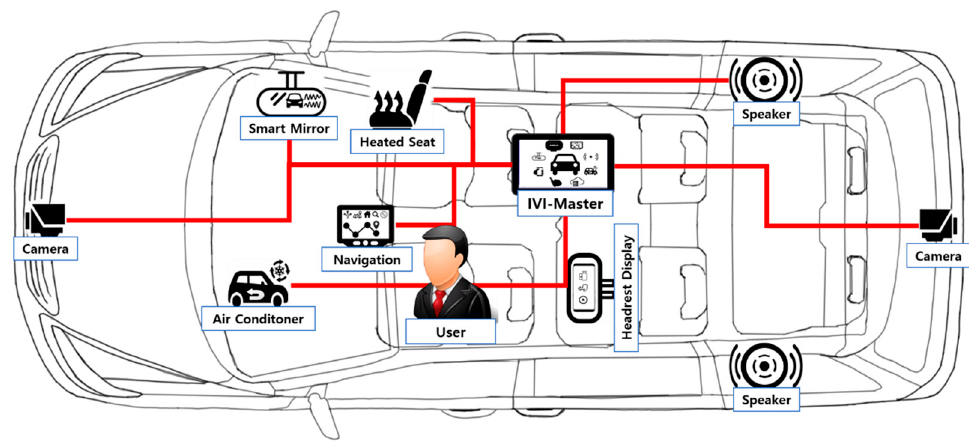
Figure 3. Configuration of proposed IVI system components.